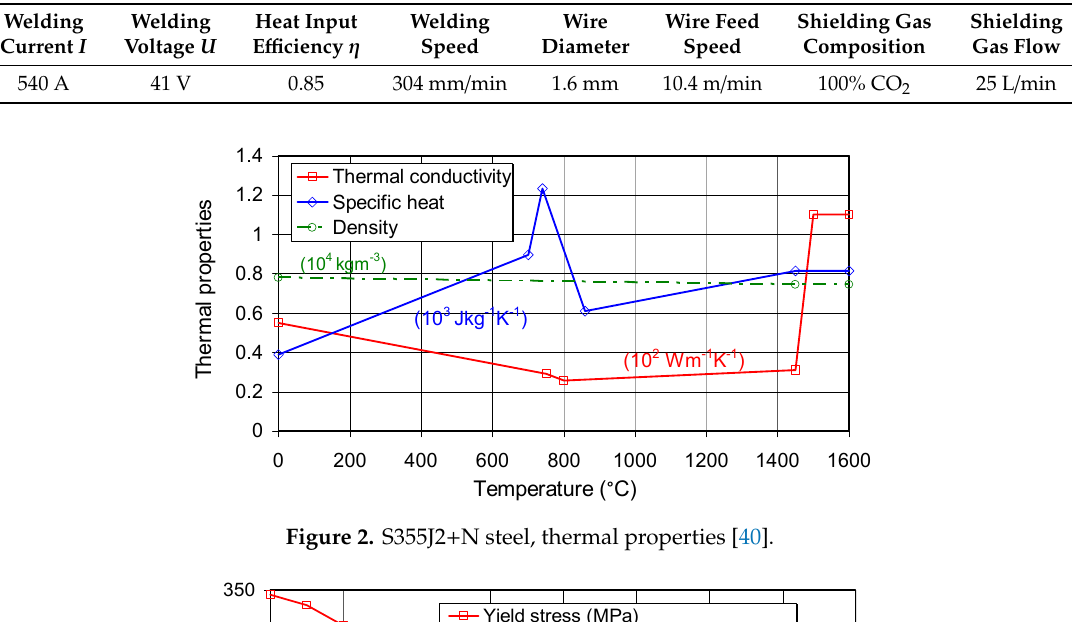
Table 2. Welding parameters.